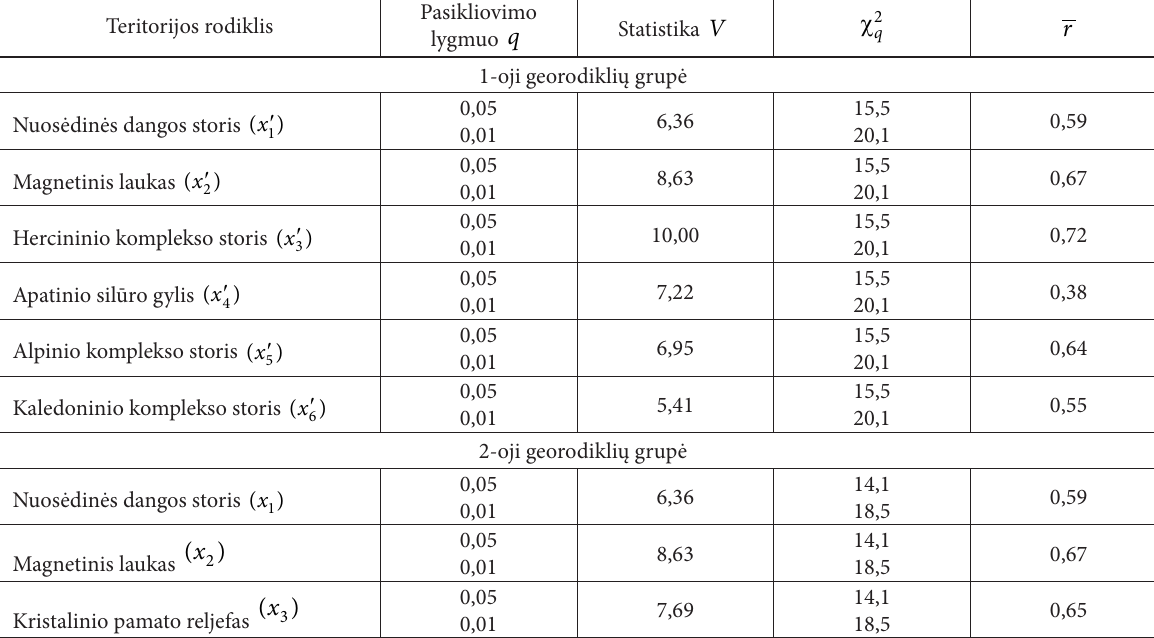
Table 3. Verification of the dependences of correlation coefficients on the general correlation space Teritorijos